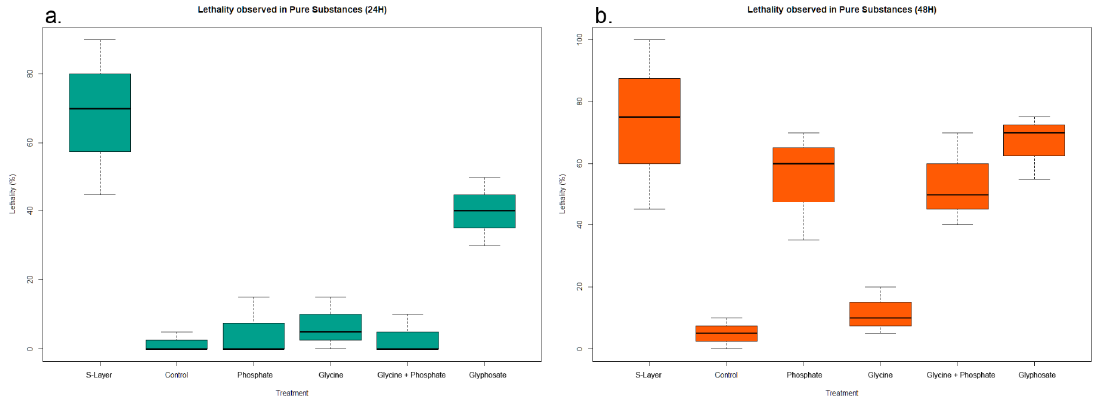
Figure 2. Lethality responses observed in the Aedes albopictus larvae after exposure to pure treatment solutions at ( a ) 24 h of exposure and ( b ) 48 h of exposure.